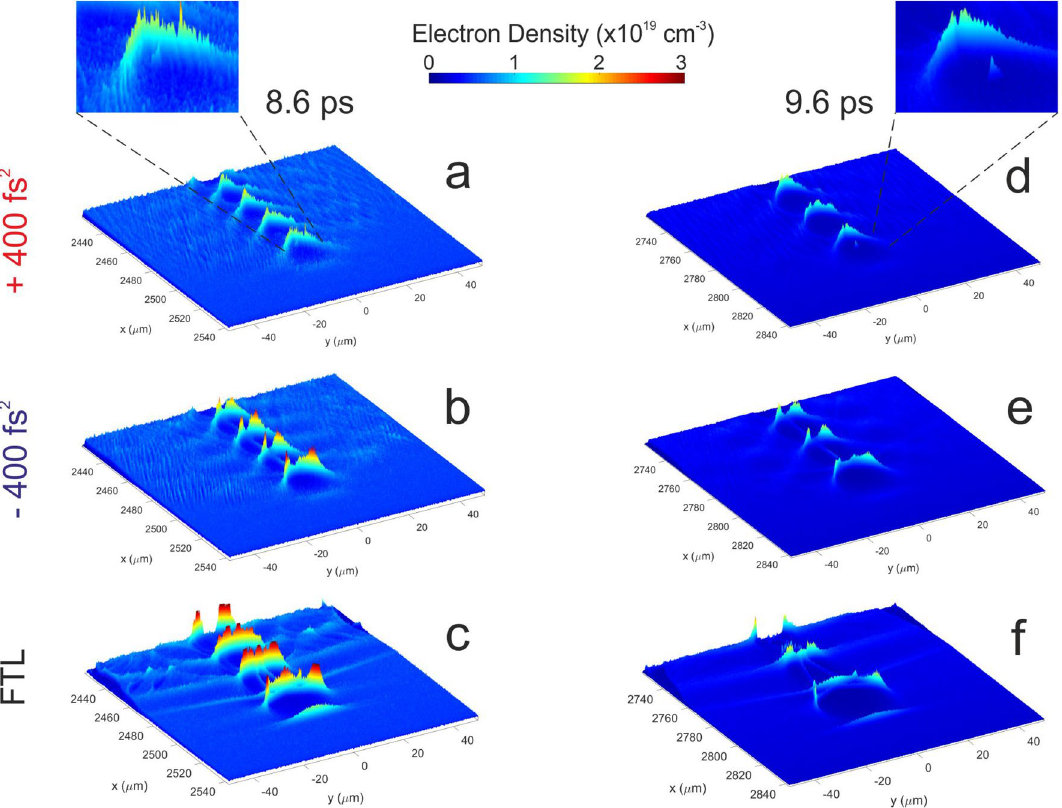
Figure 5. PIC simulation results. Formation of bubble plasma density for FTL pulses as well as positively ( + 400 fs 2 ) and negatively ( − 400 fs 2 ) chirped pulses at PIC evolution times of 8.6 ps ( a – c ) and 9.6 ps ( d – f ). A smoother plasma density bubble is evident for the positively chirped pulses that promotes the wavebreaking and subsequent acceleration of the electron beam. The wavebreaking and acceleration of the self-injected electrons for the case of + 400 fs 2 chirped pulses are clearly depicted in the zoomed pictures of graphs ( a , d